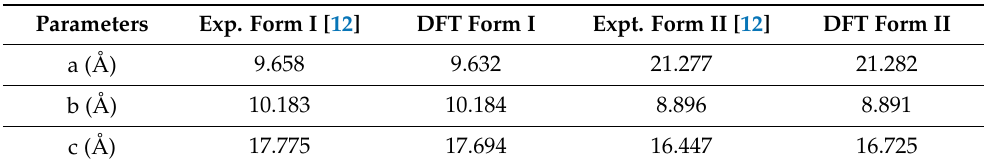
Table 1. Comparison between experimental and calculated crystal structure parameters of form I and form II of TCBZ.